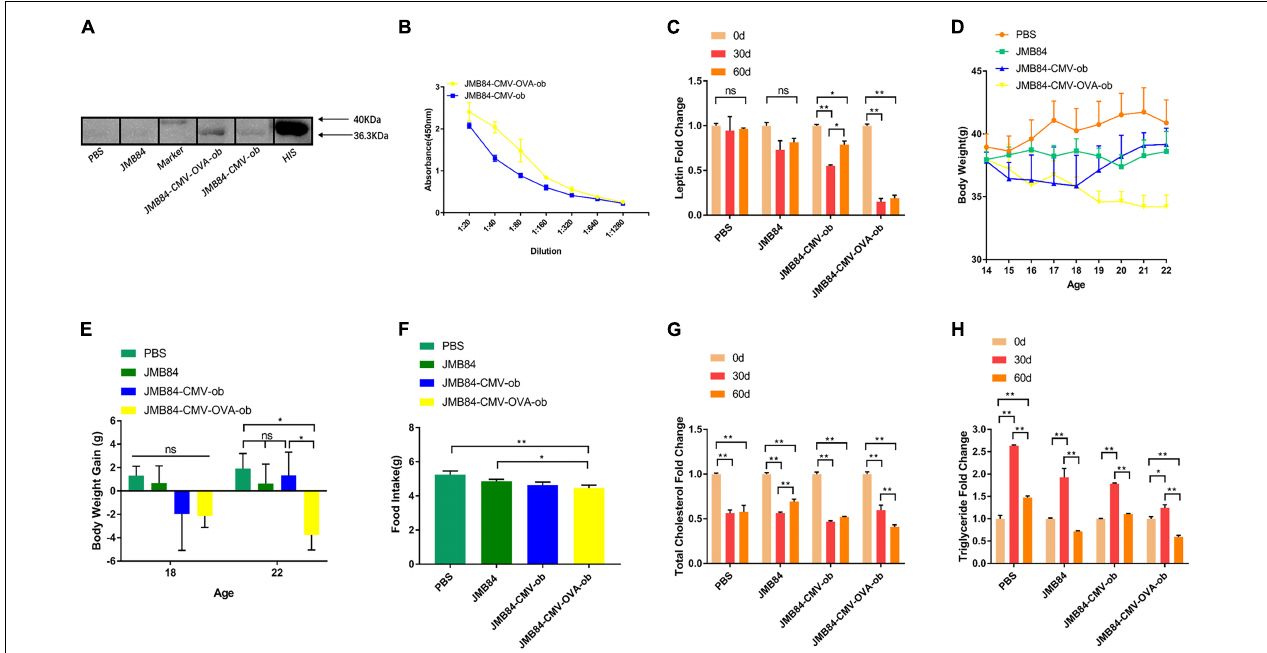
FIGURE 4 | Oral administration of ob recombinant yeast contributes to obesity control of DIOed mice. (A) WB assay result for the qualitative detection of anti-leptin antibodies in different antiserums (Day60) from different treatments. (B) ELISA result for anti-leptin antibody titering in the antiserums (Day60) from the oral immunized mice by ob recombinant yeast. (C) The changes in circulating leptin were detected by ELISA in the antiserums (Day0, Day30, and Day60) from different treatments. (D) The weekly average body weight of the mice from different treatments. The age was indicated as weeks, and the mice were orally immunized at 14-week-old. (E) The comparison of the average body weight gain of the mice from different treatments at the middle (Day28, 18-week-old) and the end (Day56, 22-week-old) of oral immunization. (F) The comparison of the average daily feed intake of the mice from different treatments during the oral immunization. (G,H) The changes of total cholesterol and triglyceride were detected in the antiserums (Day0, Day30, and Day60) from different treatments. The “ns” indicates statistical significance at a P value of > 0.05; * represents P < 0.05; ** represents P <